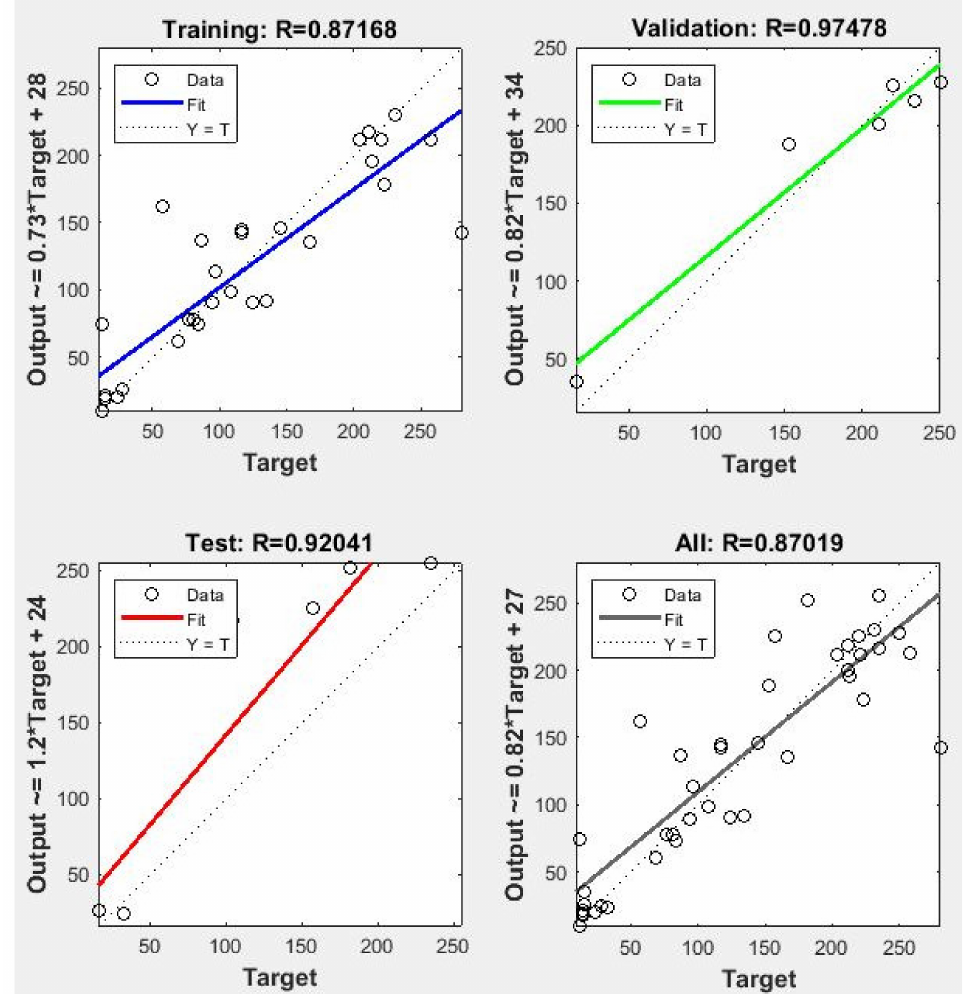
Figure 3. Outputs of the model using training, validation, testing, and overall